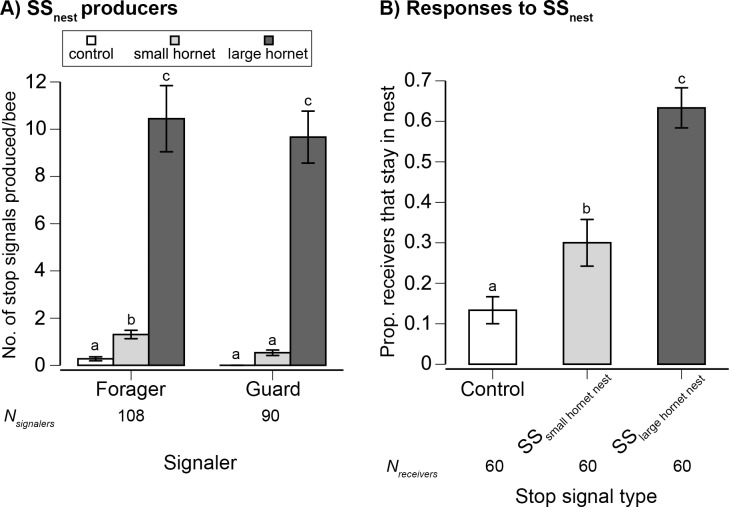
The effect of nest attacks upon (A) stop signal (SS nest) production by foragers and guards. (B) Receivers of SS nest increasingly remained inside the nest according to the type of predator eliciting the signal. Graphs show the mean ± 1 standard error. Different letters indicate significant differences (Tukey’s HSD test, p < 0.05).